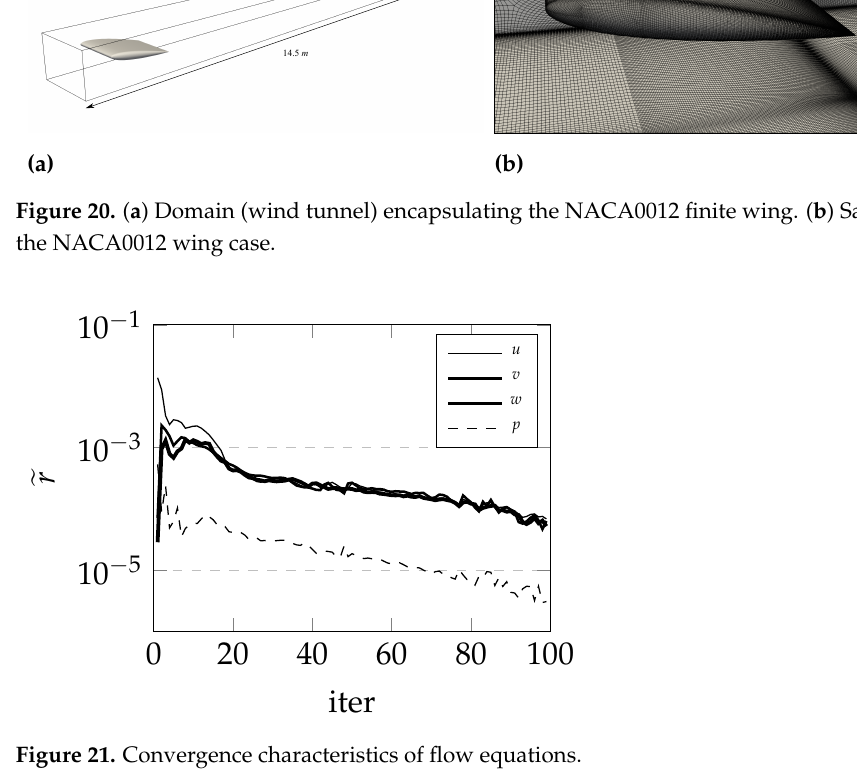
Figure 22. Evaluation lines